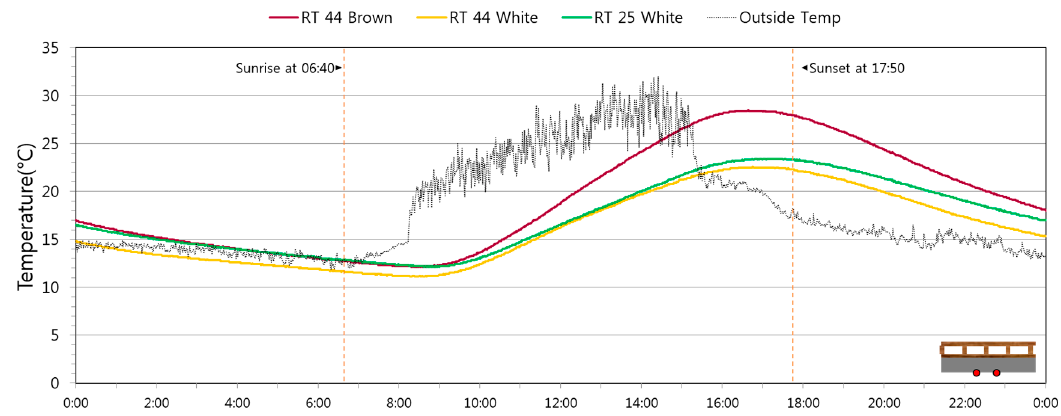
Figure 13. Variation in chamber ceiling temperature with finishing color and PCM.